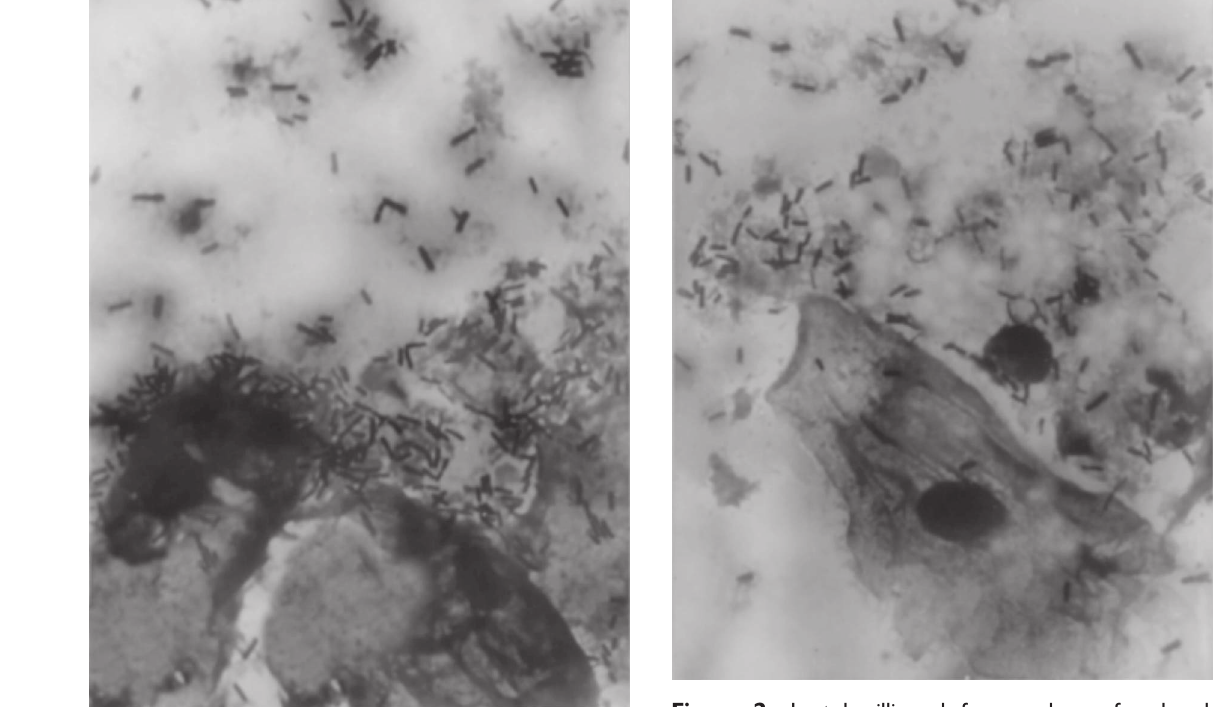
Figure 2 Lactobacilli and free nucleus of a lysed